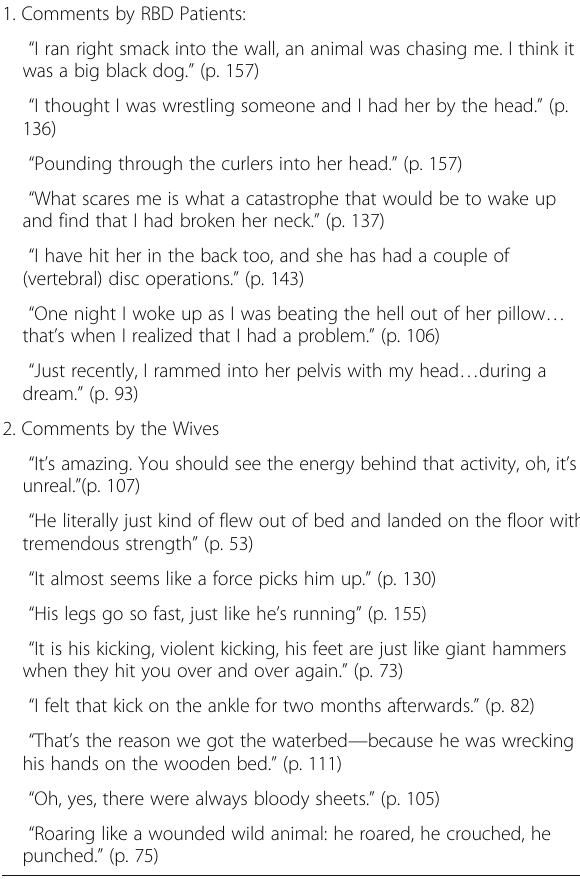
Table 3 Comments by patients and spouses on RBD